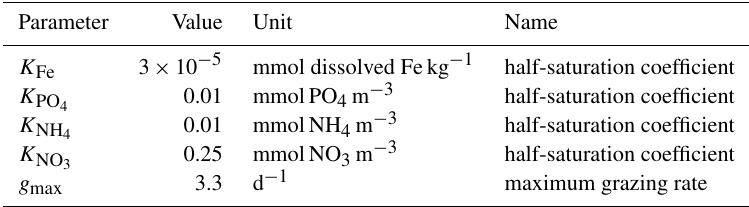
Table A5. Parameter values used in MARBL to compute the production and loss of small phytoplankton. Parameter